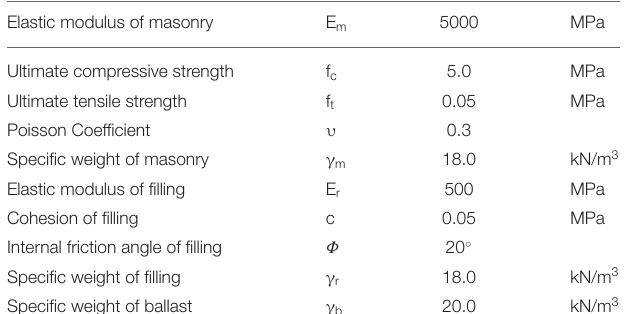
TABLE 1 | Resistance Characteristics of the constitutive elements in the model. Elastic modulus of masonry